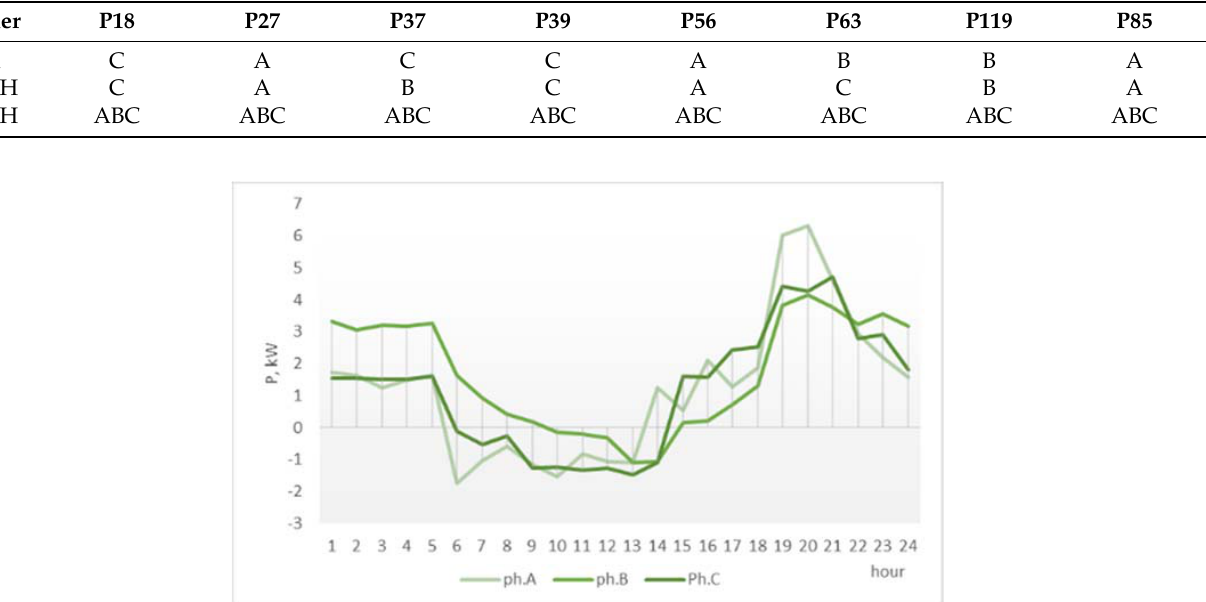
Table 7. Prosumer surplus shifting on the three phases in network R121. Table 8. Power losses in network R121, hourly and total, in the interval 06:00–18:00, kW.